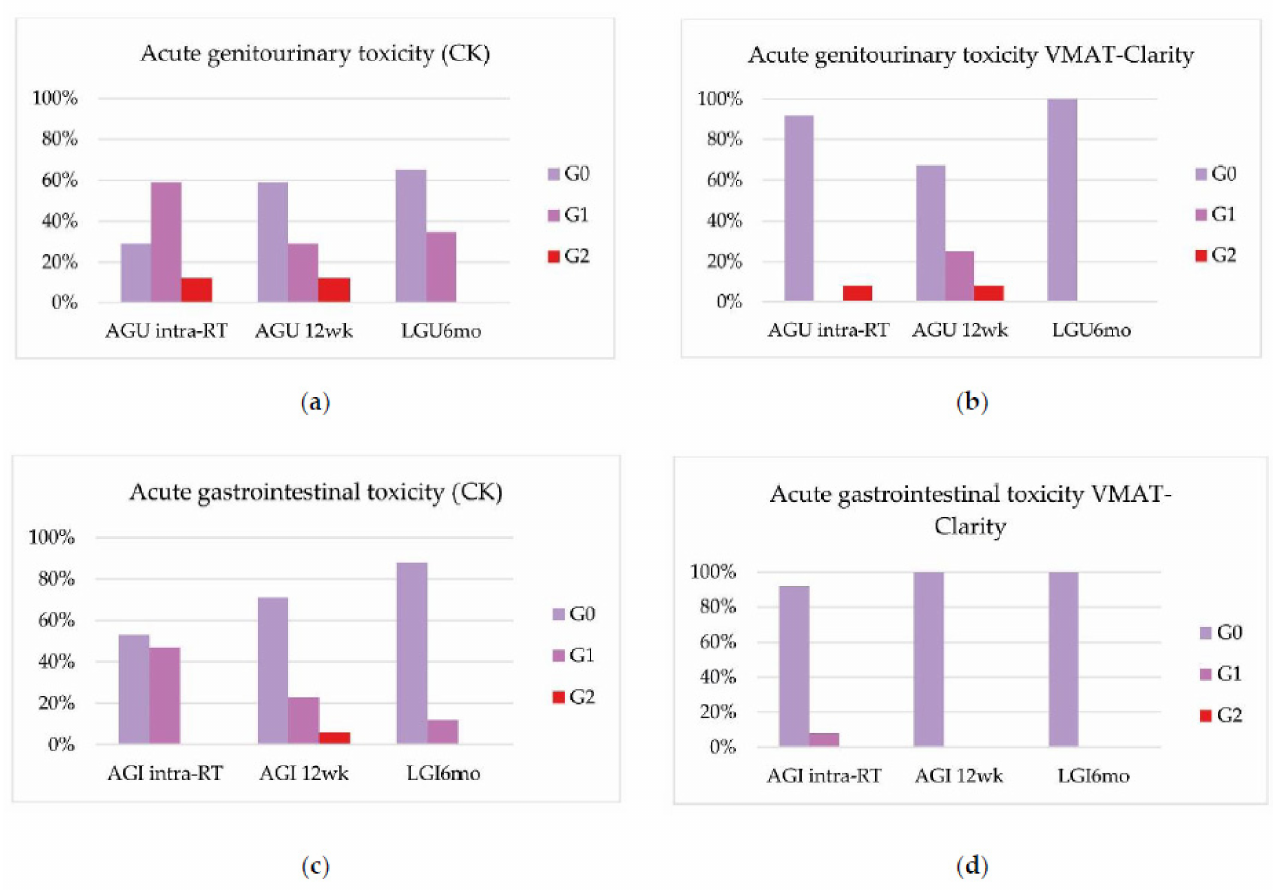
Figure 2. Acute genitourinary toxicity (AGU) in Cyberknife ® ( a ) and VMAT-Clarity ® ( b ) pa- tient groups. Acute gastrointestinal toxicity (AGI) in Cyberknife ® ( c ) and VMAT-Clarity ® ( d ) pa- tient groups.